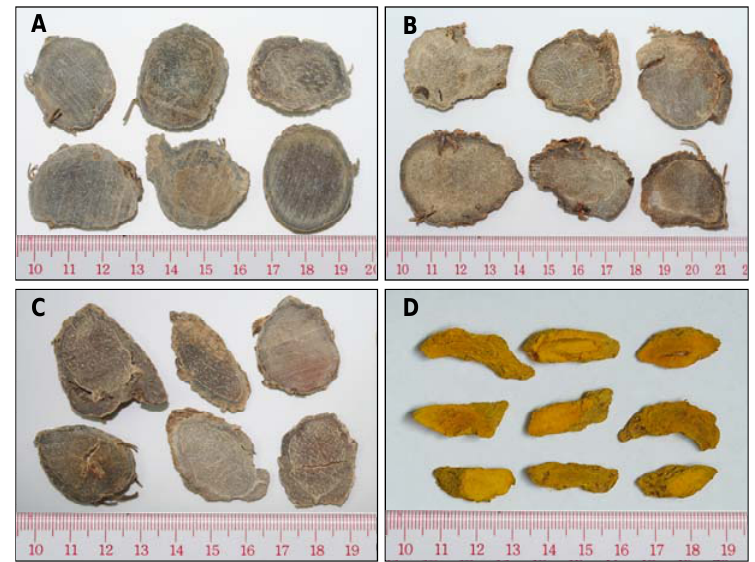
Figure 3. The sliced raw materials of C. kwangsiensi (A), C. phaeocaulis (B), C. wenyujin (C) and C. longa